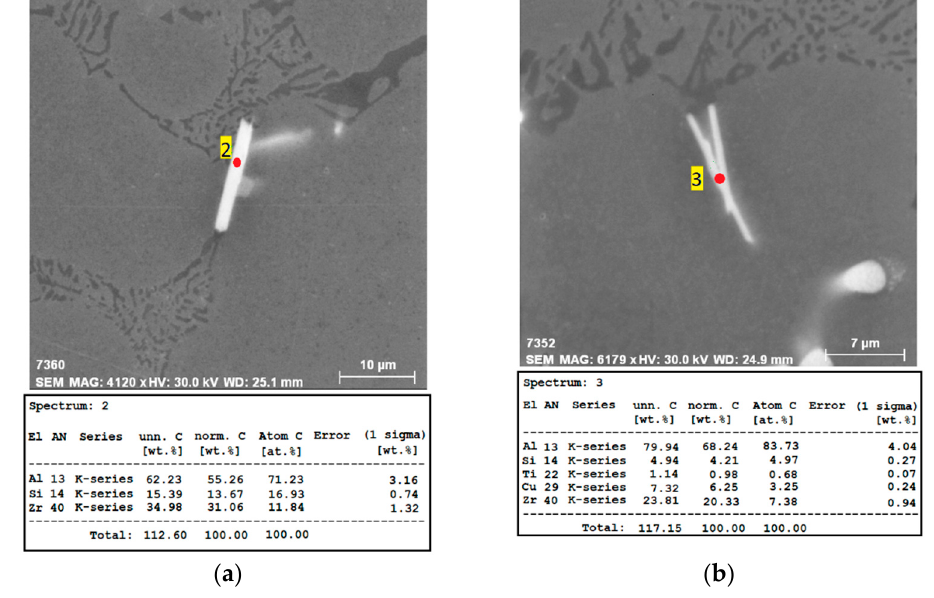
Figure 13. Morphology of Zr phases in the AlSi5Cu2Mg alloy with the corresponding EDX spectrum (as ‐ cast, H 2 SO 4 etch.): ( a ) 0.20 wt. % Zr addition; ( b ) 0.15 wt. % Zr addition .